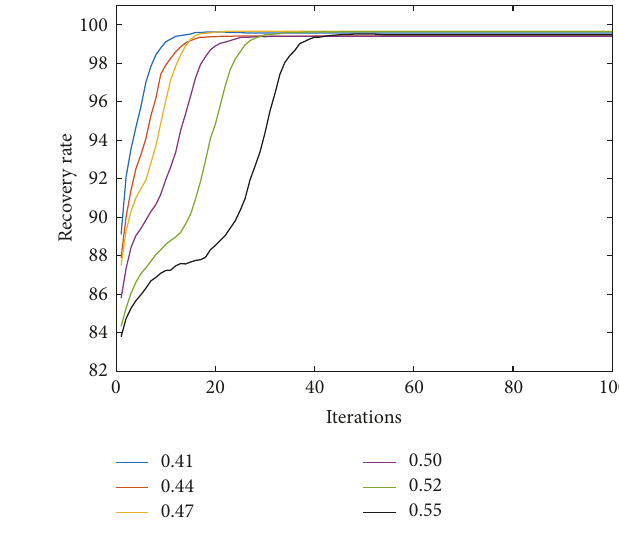
Figure 3: The recovery curves.